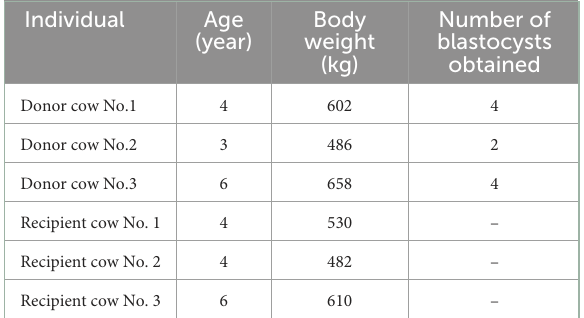
TABLE 1 The information of the donor and recipient